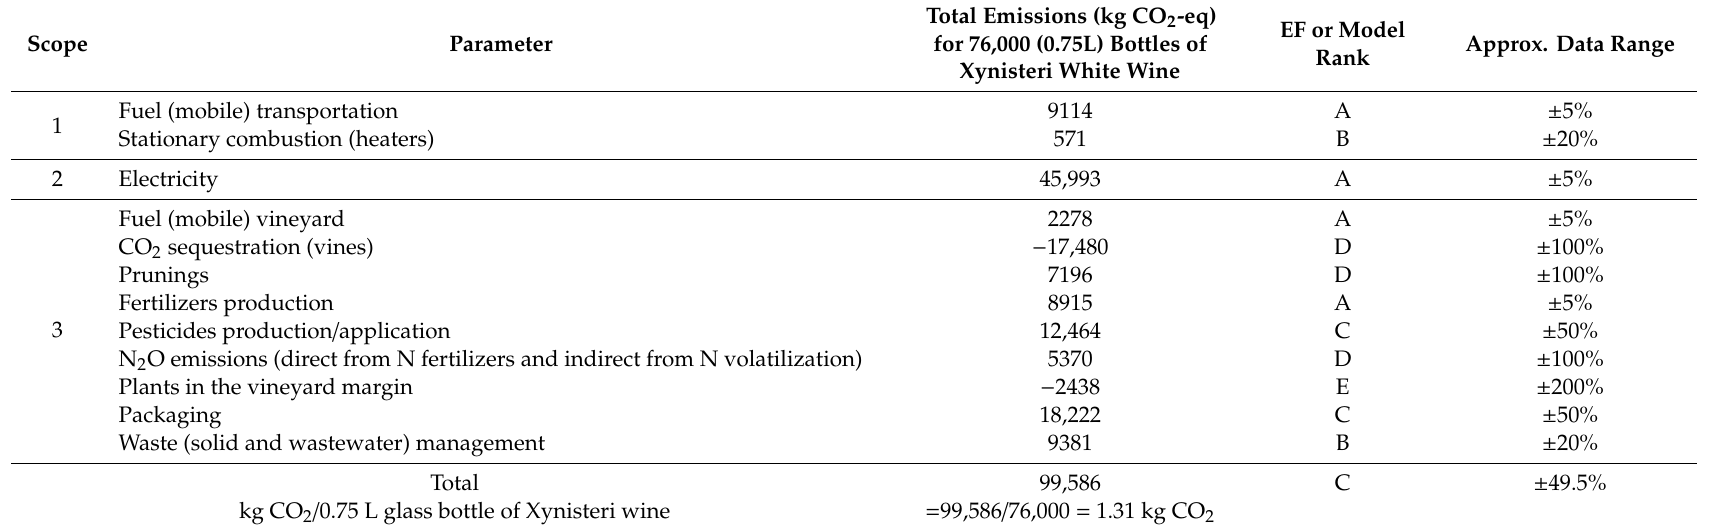
Table 2. Total emissions for the annual Xynisteri production in the winery presented per emission scope. For the uncertainty analysis (emission factor (EF) or model rank) see also Table S2 (Supplementary